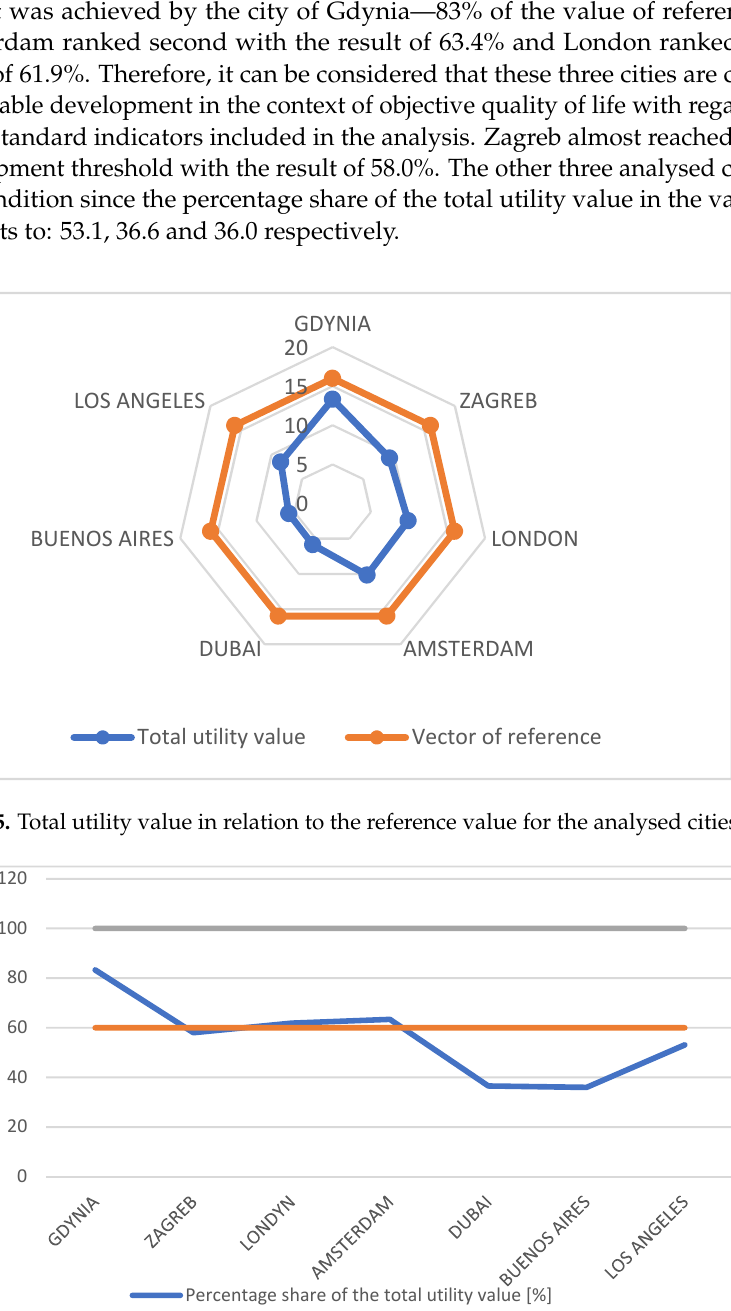
Figure 4. Comparison of total utility by dimensions for the analysed cities.